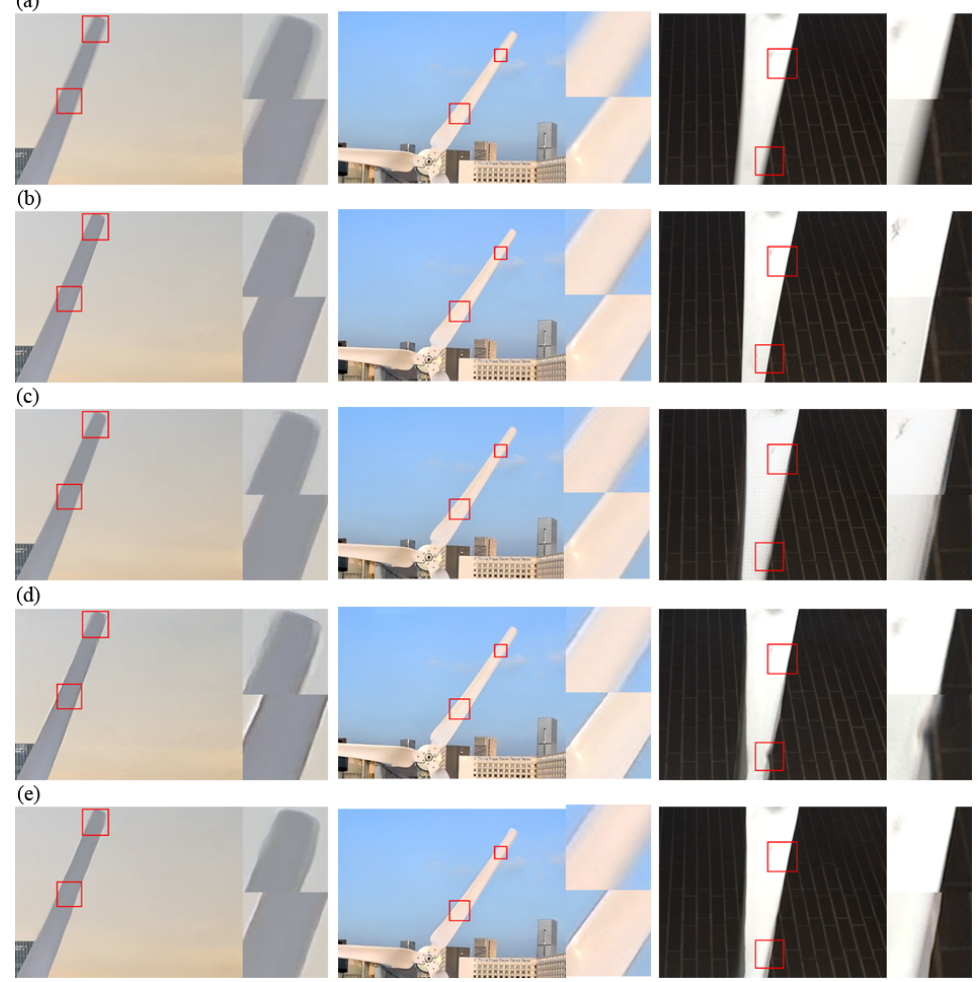
Figure 14. Motion deblurring results for images captured with a rotational angular velocity of 4–7 rad/s (the blur length increases from left to right column): ( a ) Blurred images; ( b ) Sharp images; ( c ) Restored images using the DeblurGAN; ( d ) Restored images using the M-DeblurGANv2; ( e ) Restored images using the I-DeblurGANv2.